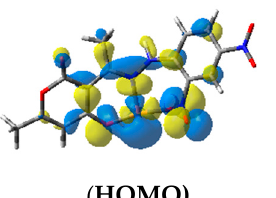
( b ) Figure 1. Optimized (by the UB3LYP/6-31G* method) ( a ) copper complex geometries and their UV– Vis spectra; ( b ) UV–Visible spectra of HLCuCl complex in MeCN, methanol, and chloroform, and in